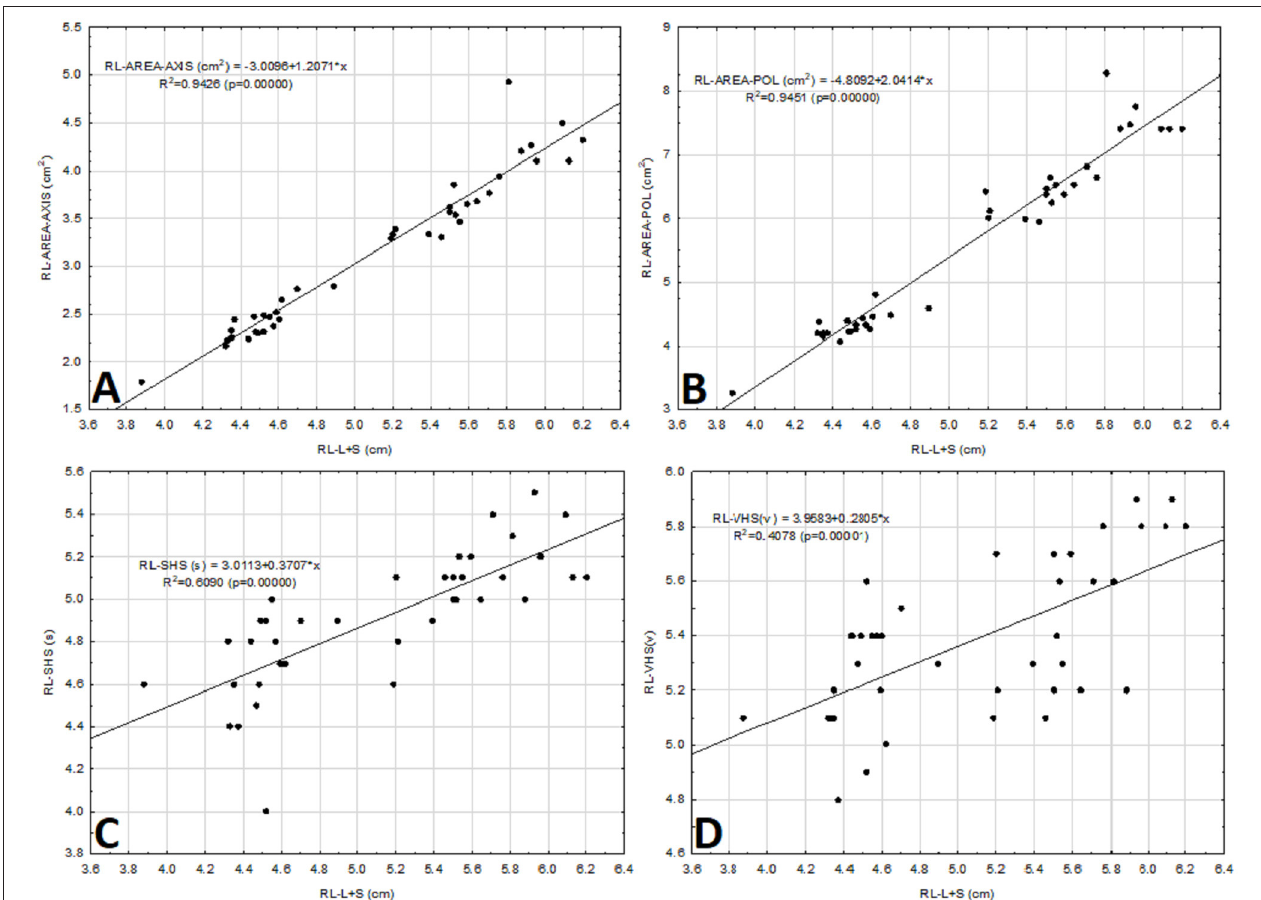
FIGURE 6 | Scatter diagram between the sum of the long and the short axes of the cardiac silhouette [L + S (cm)] vs. the cardiac area-axis [AREA-AXIS (cm 2 )], open polygon cardiac area [AREA-POL (cm 2 )], sternebral heart scale [SHS (s)], and vertebral heart scale [VHS (v)] in the right lateral projection (RL) obtained from 40 clinically normal ferrets (A–D) . The straight line represents the linear equation adjusted to the data points. The corresponding equation is